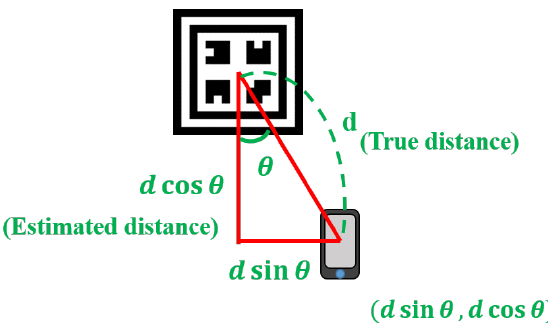
Figure5. The error of the distance estimation method